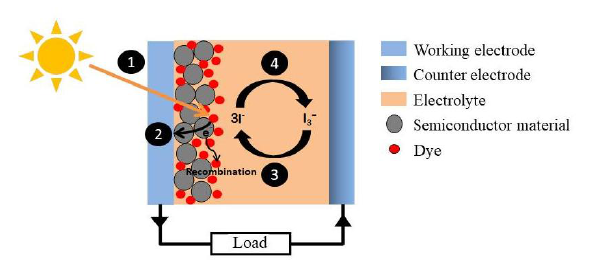
Fig. 1. The structure of